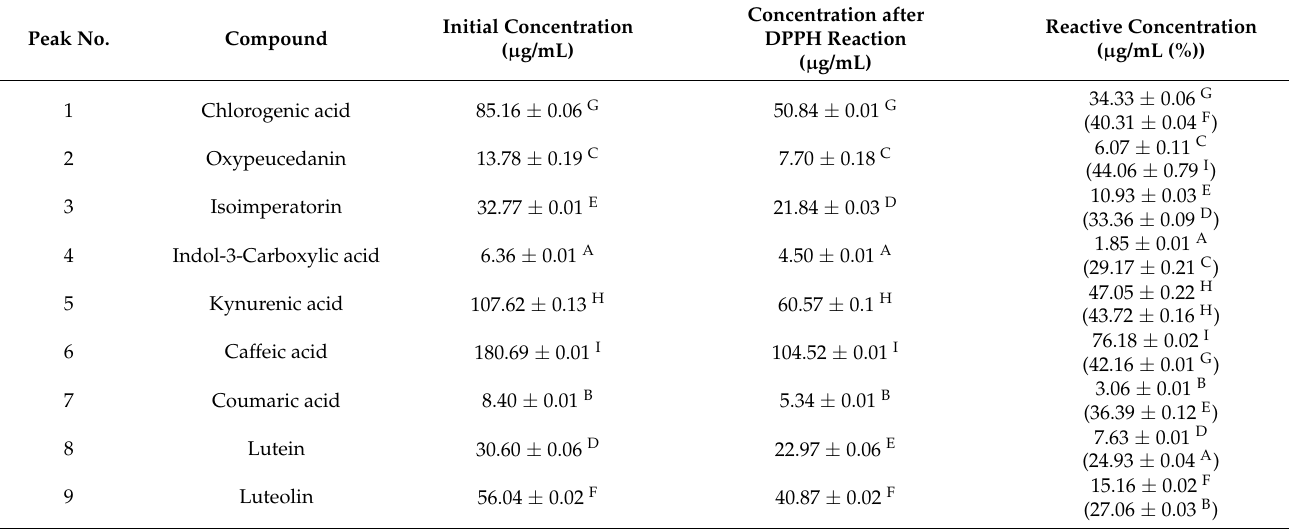
Table 3. Screening of antioxidants in the Gynura procumbens polyphenolic compounds. Peak